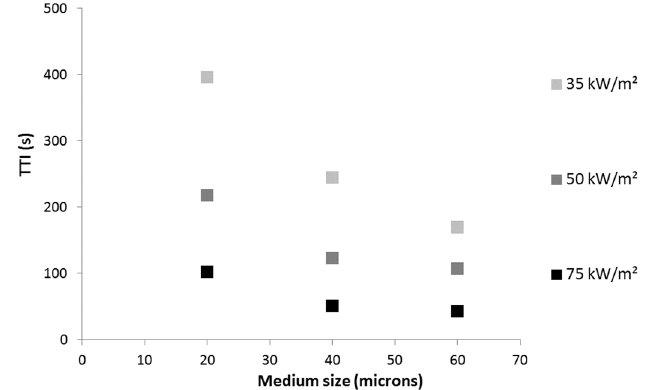
Figure 9. Time ‐ to ‐ ignition (s) versus medium particle size for LDPE coated with 5A20, 5A40 and 5A60 coatings at various heat flux.